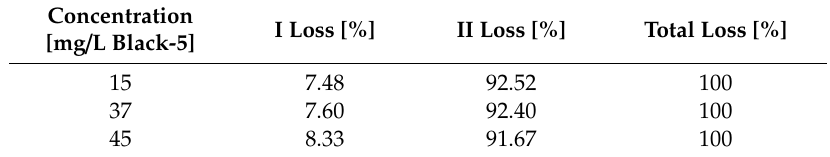
Figure 11. TG curves of purified MWCNTs after adsorption of the different solutions.